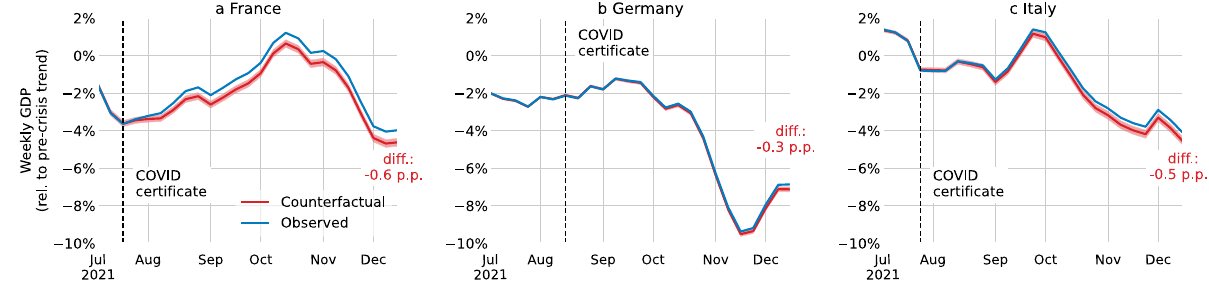
Fig. 3 Estimated weekly GDP with and without COVID certi fi cates. For France ( a ), Germany ( b ), and Italy ( c ), weekly GDP (3-week rolling average) in the actual intervention deployment (blue) and in the no-intervention counterfactual scenario (red). The red shaded area is the 95% con fi dence interval centred around the main estimate. The black dashed vertical line is the date of the announcement of the COVID certi